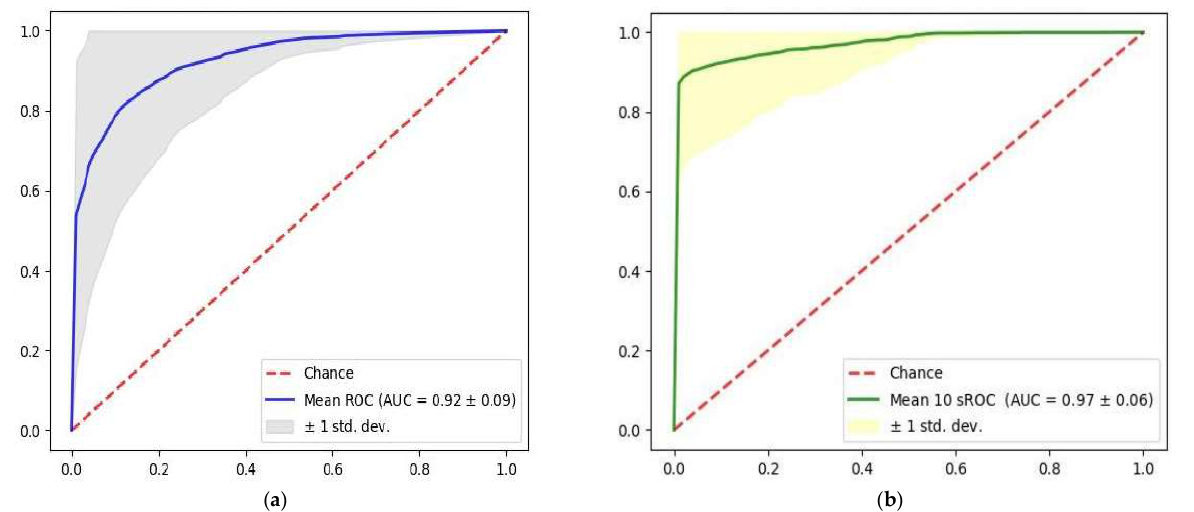
Figure 2. Receiver Operating Curve of model prediction based on ( a ) single heartbeat and ( b ) 10 s majority voting. Table 3. Performance of model prediction based on single heartbeat and 10 s majority voting.